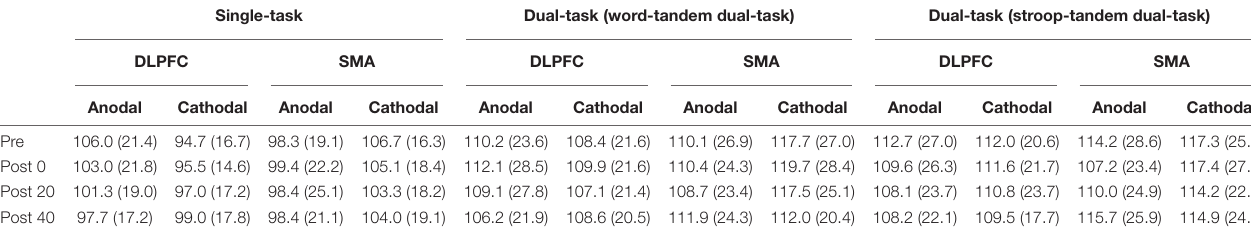
TABLE 1 | The result of the COP path length (cm) in the tandem task under the single- and dual-task condition.